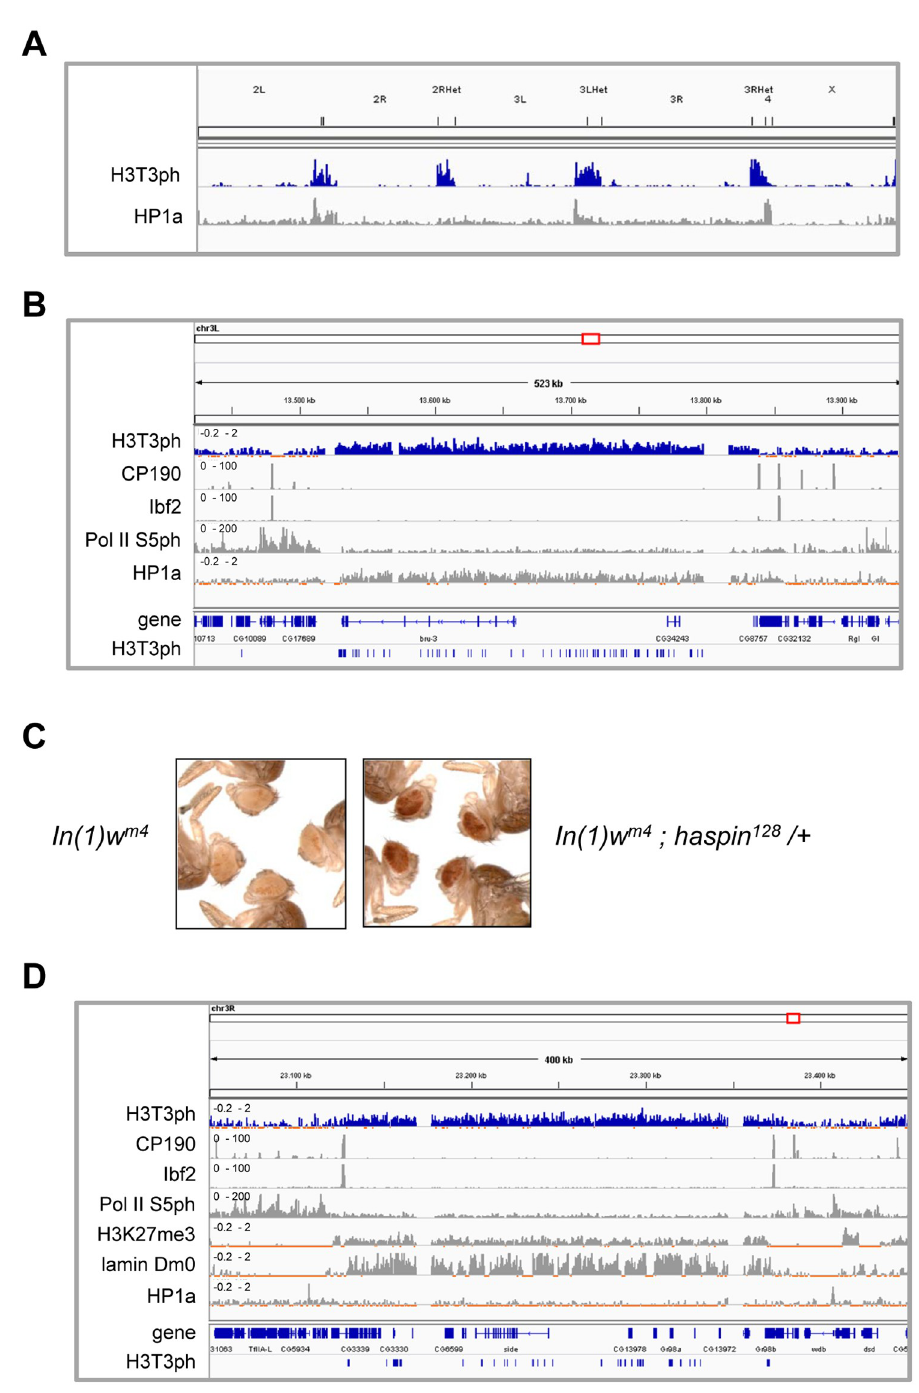
Fig 4. Haspin is a suppressor of position-effect variegation. A) ChIP-seq data for H3T3ph genome-wide localization. Enriched regions of HP1a (modENCODE data, see S1 Text) are depicted below. B) ChIP-seq data for H3T3ph over a region of 500 kb in chromosome 3 in Drosophila S2 cells. Binding profiles of CP190 and Ibf2 [66], Pol II S5ph and HP1a (modENCODE data) are shown. H3T3ph peaks are depicted in last row. C) Effect of haspin 128 mutation on position-effect variegation in In(1)w m4 males (n = 3). D) Representative ChIP-seq data for H3T3ph over a 400 kb region of chromosome 3R in Drosophila S2 cells. Binding profiles of CP190 and Ibf2 [66], Pol II S5ph, H3K27me3 and HP1a (modENCODE data, see S1 Text) and lamin Dm0 [69] are shown. H3T3ph peaks are depicted in last row.